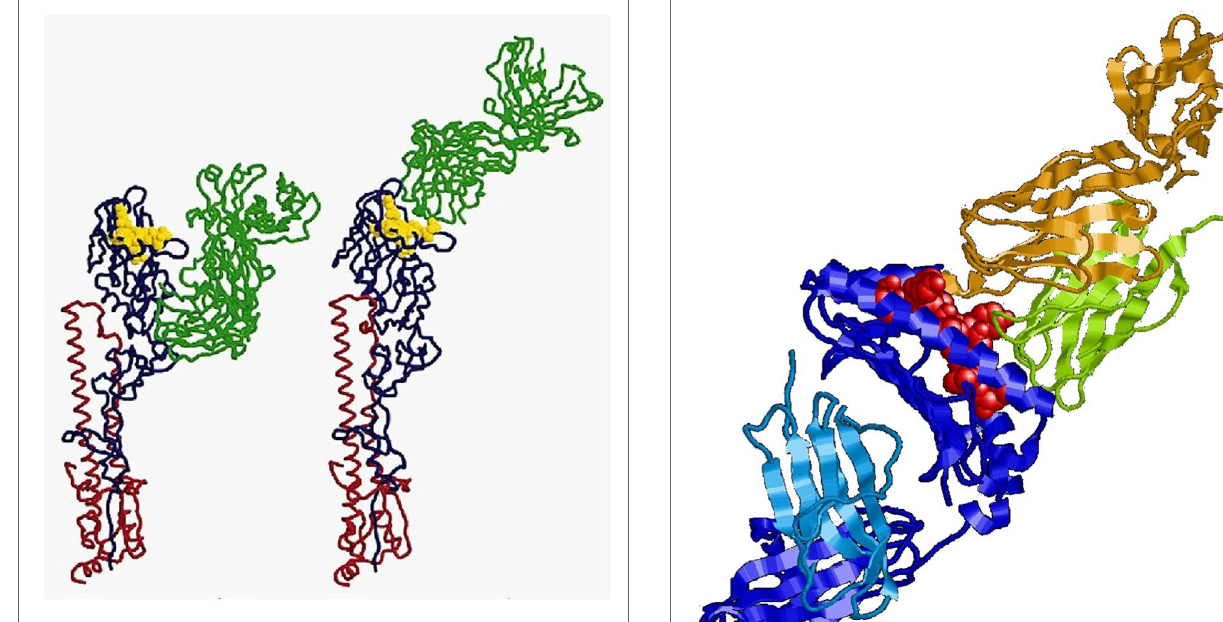
FiGUre 1 | a complex of influenza hemagglutinin with a neutralizing antibody that binds outside the virus receptor-binding site . Ribbon diagram of the complex showing one BHA monomer (HA1 in blue, HA2 in red) and the HC45 Fab (in green); the receptor-binding site is shown in yellow; for comparison, the X31 HA–HC19 Fab complex is shown on the right (9). Reprinted by permission from Macmillan Publishers Ltd.: Nature Structural and Molecular Biology (9), copyright